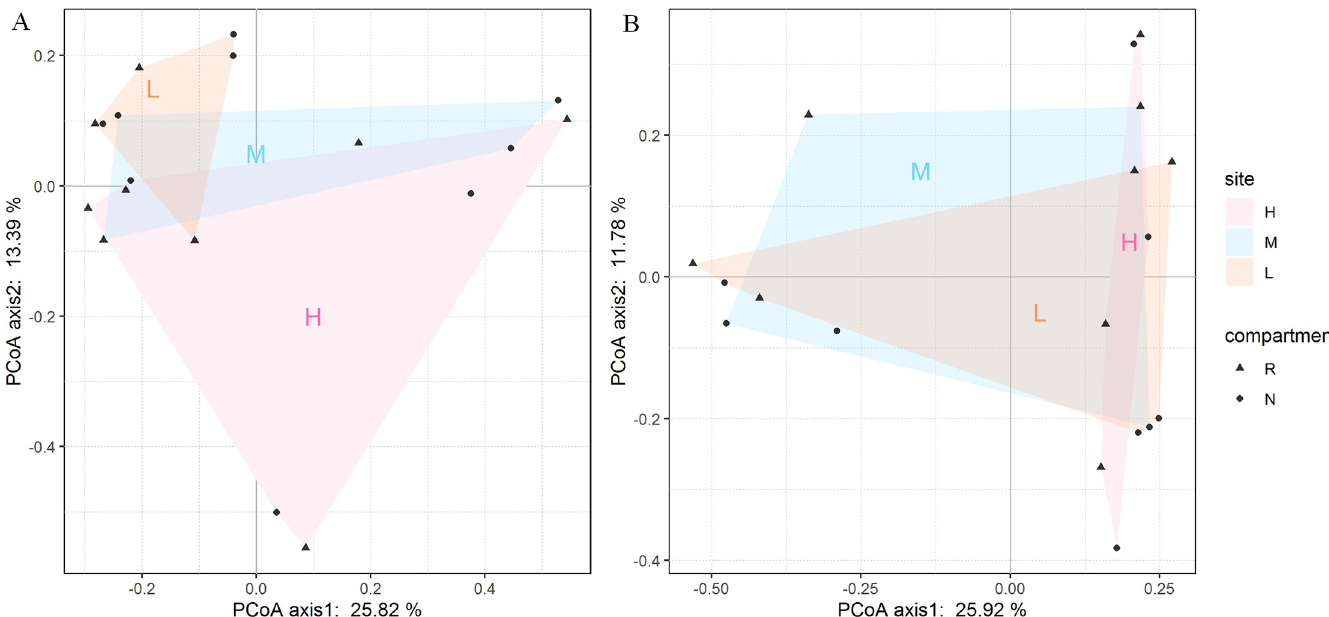
Fig 6. PCoA analysis of rhizobacteria communities was based on Bray-Curtis distance at OTU level. H (high water and salt), M (medium water and salt), L (low water and salt). R (rhizosphere soil), N (bulk soil).